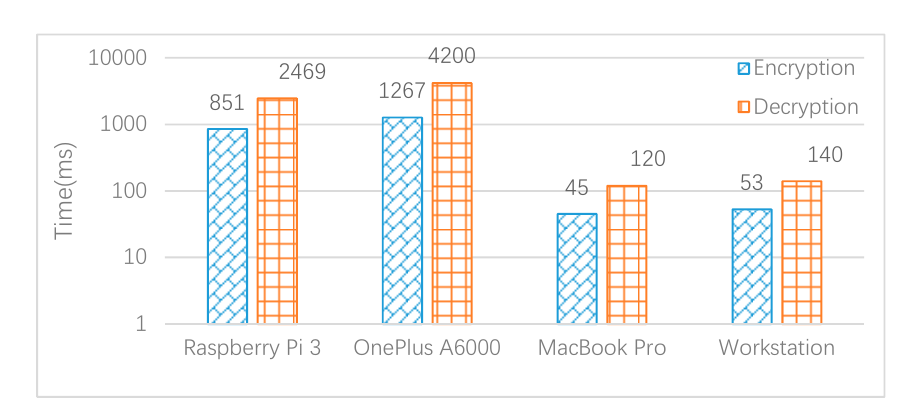
Figure 4. DEM’s encryption and decryption performance (using the block cipher).